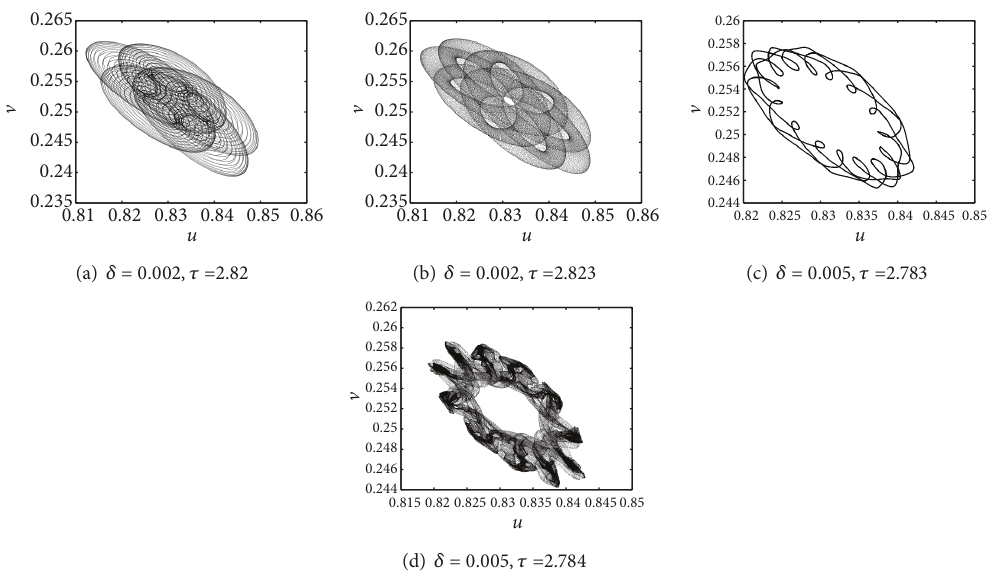
Figure 15: Phase diagrams corresponding to Figures 14(b) and 14(c), demonstrating the predator-prey dynamics of the coupled network. (a)-(d) are plotted with (𝑢, V ) states at one